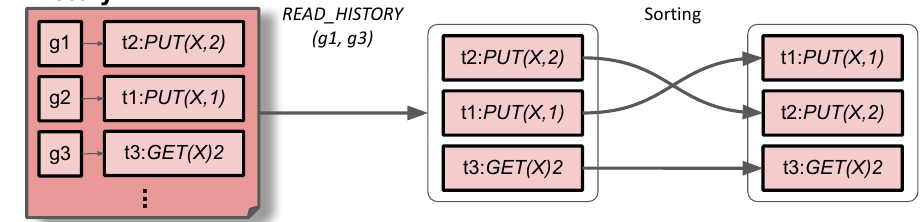
Figure 4. Client sorts the entries based on timestamps attached on each operation request.